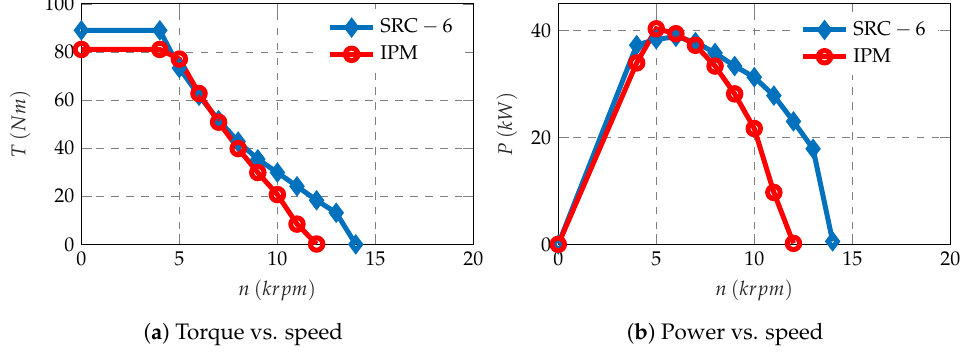
Figure 5. Torque and Power of the SRC-6 machine.